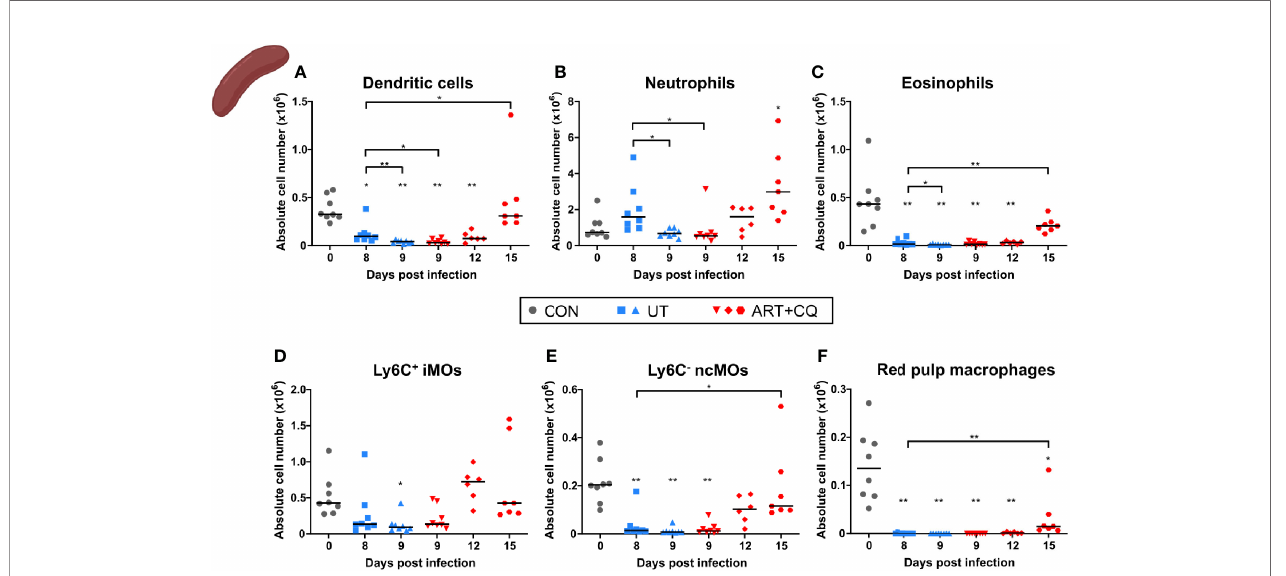
FIGURE 5 | Dynamics of the splenic myeloid cell populations during resolution of malaria-associated acute respiratory distress syndrome (MA-ARDS). C57BL/6 mice were infected with Pb NK65. Mice were injected daily from 8 until 12 days p.i. with 10 mg/kg ART + 30 mg/kg CQ. Mice were dissected at the indicated days p.i. Leukocytes were isolated from the spleen and fl ow cytometry was performed. (A – F) The absolute numbers of dendritic cells (CD45 + Lin − MHC-II + CD11c + ), neutrophils (CD45 + Lin − CD11b + Ly6G + ), eosinophils (CD45 + CD11b + MHC-II − CD11c − Ly6G − Ly6C − SSC-A hi ), Ly6C + in fl ammatory monocytes (iMOs; CD45 + Lin − CD11b + MHC-II − CD11c − SSC-A lo Ly6C + ), Ly6C − non-classical monocytes (ncMOs; CD45 + Lin − CD11b + MHC-II − CD11c − SSC-A lo Ly6C − ), and red pulp an individual mouse. n=8 for CON on day 0, UT at 8 and 9 days p.i and ART+CQ at 9 days p.i., n=6 for ART+CQ at 12 days p.i., n=7 for ART+CQ at 15 days